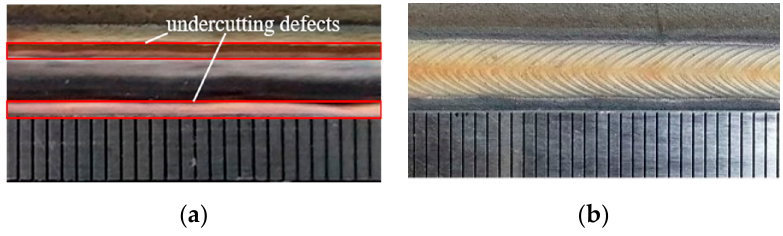
Figure 20. The captured arc images: ( a ) by camera 2, ( b ) by camera 1, and ( c ) by camera 1.